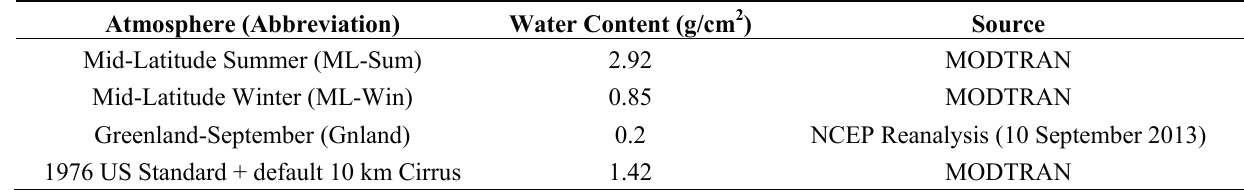
Table 6. Atmospheres used in the out-of-band response simulations.